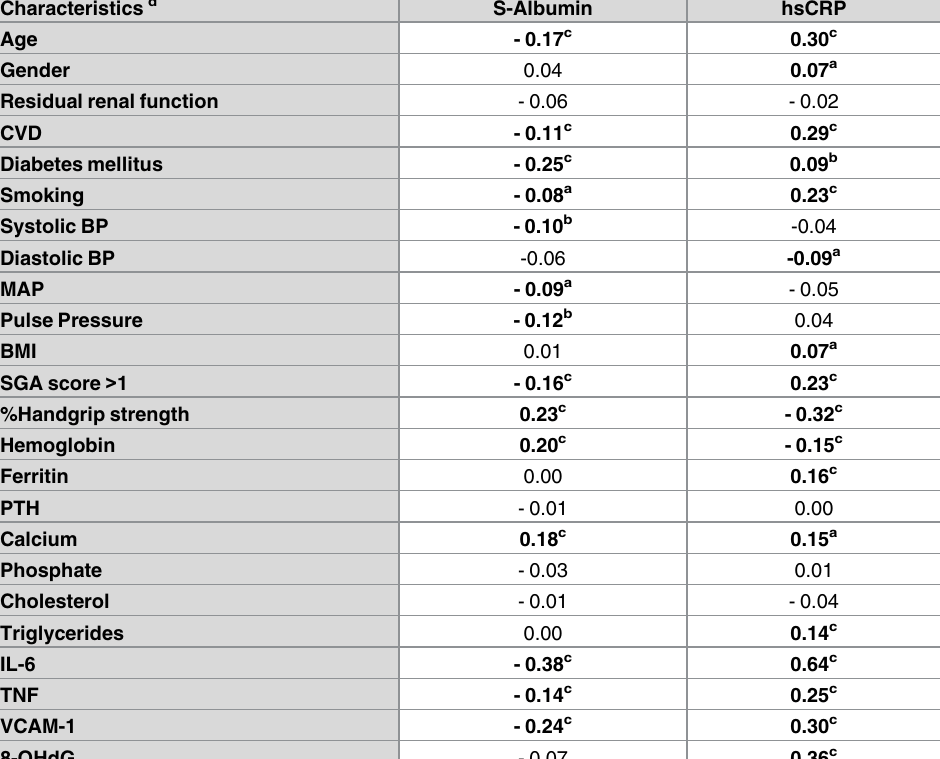
Table 2. Univariate Spearman’sRho correlations of S-albumin and hsCRP with other parameters in 822 patients with CKD stage 5. Characteristics